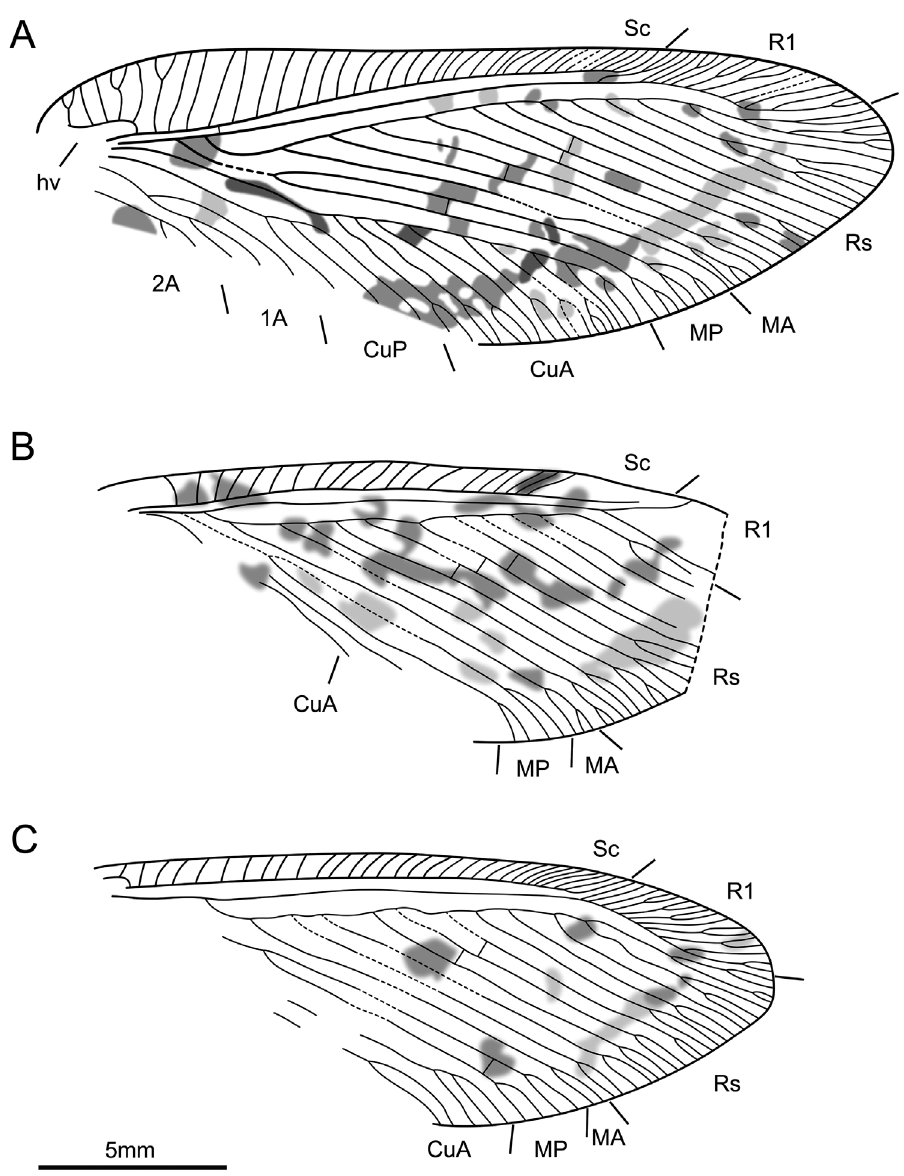
Figure 4. Lasiosmylus longus sp. n. (holotype CNU-NEU-LB2015003), line drawings. A right forewing B left hind wing C right hind wing. Scale bars: 5 mm ( A–C